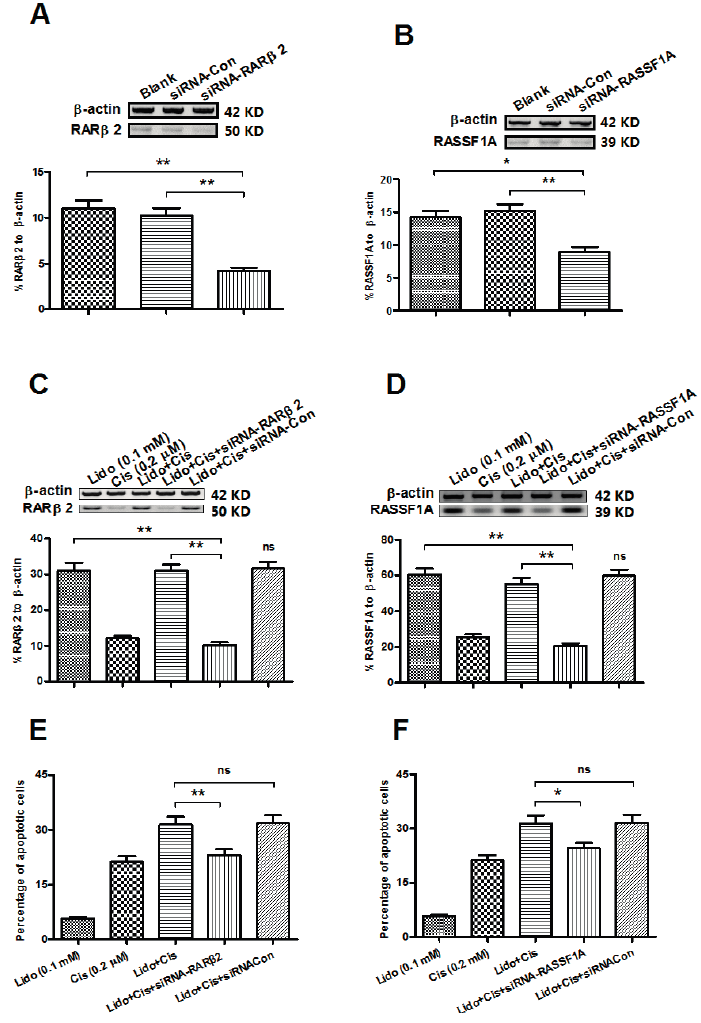
Figure 6. Transfection of RAR β 2- or RASSF1A- specific siRNA inhibits the lidocaine and cisplatin-induced apoptosis in MCF-7 cells. ( A – D ) Western blot analysis of RAR β 2 ( A , C ) or RASSF1A ( B , D ) expression in MCF-7 cells post-transfection of the RAR β 2- or RASSF1A -specific siRNA, without ( A , B ) or with ( C , D ) the lidocane and/or cisplatin treatment; ( E , F ) Apoptotic cells induced by the combined treatment with 0.1 mM lidocaine and 0.2 μ M cisplatin for 48 h, post-transfection of RAR β 2- ( E ) or RASSF1A -specific